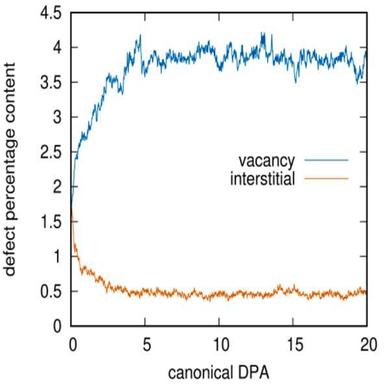
Isolated (non-clustered) defect content in bcc Fe plotted as a function of dose, measured as canonical displacement per atom (cdpa). These high dose simulations suggest that while the onset of the asymptotic microstructural dynamic steady state occurs at the dose close to 2.5 cdpa, the ultimate steady state microstructure develops at a somewhat higher dose close to 5 cdpa, in agreement with experimental observations .